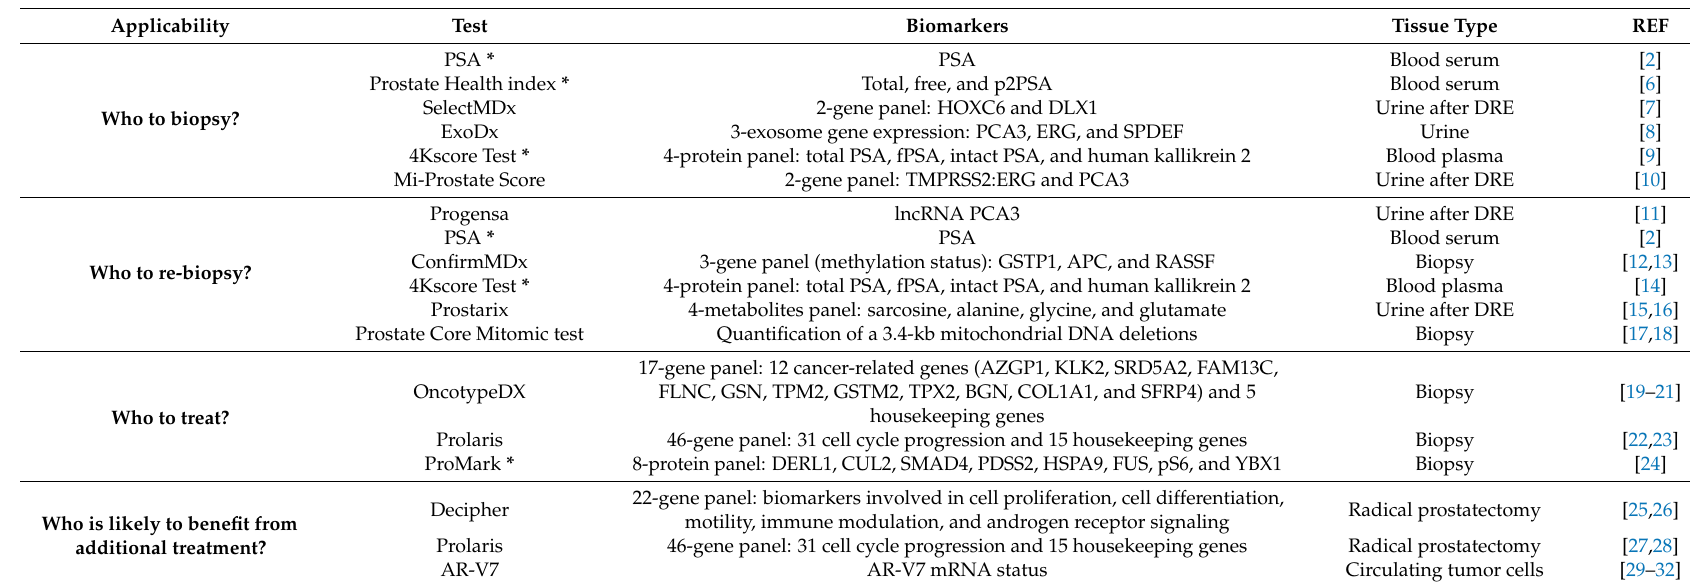
Table 1. Overview on the commercially available biomarker-based